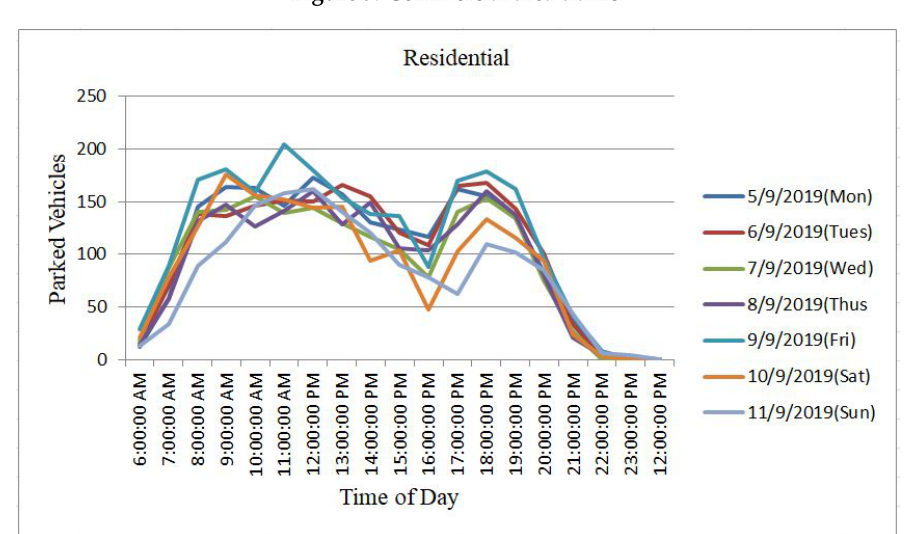
Figure 10. Residential area